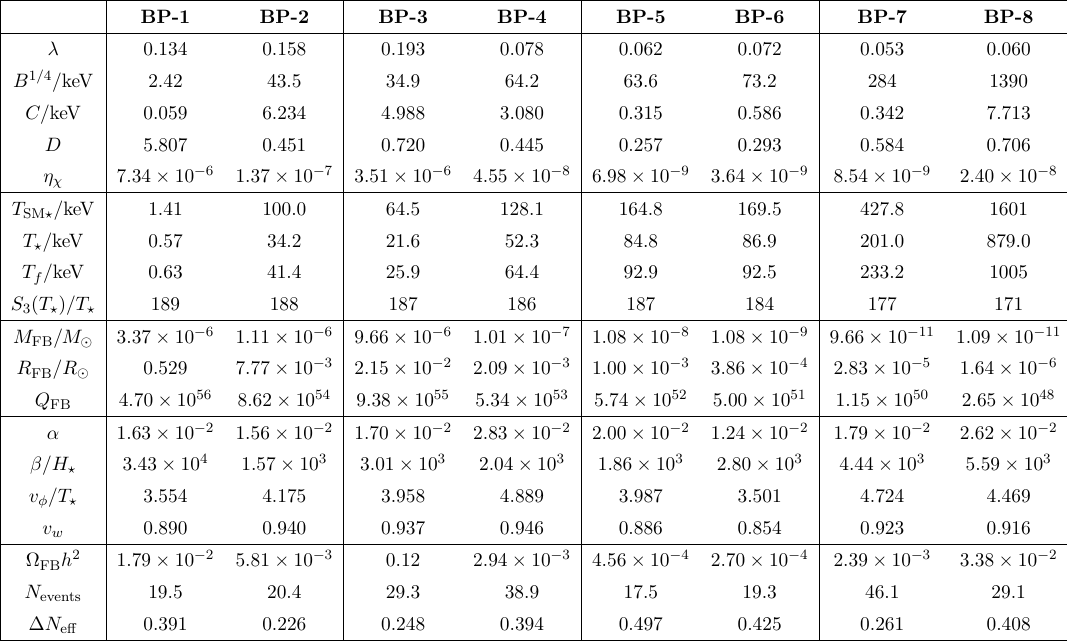
Table 1 . Benchmark points with A = 0 . 1 . N events is the number of microlensing events expected in 70 hours of observation of M31 by